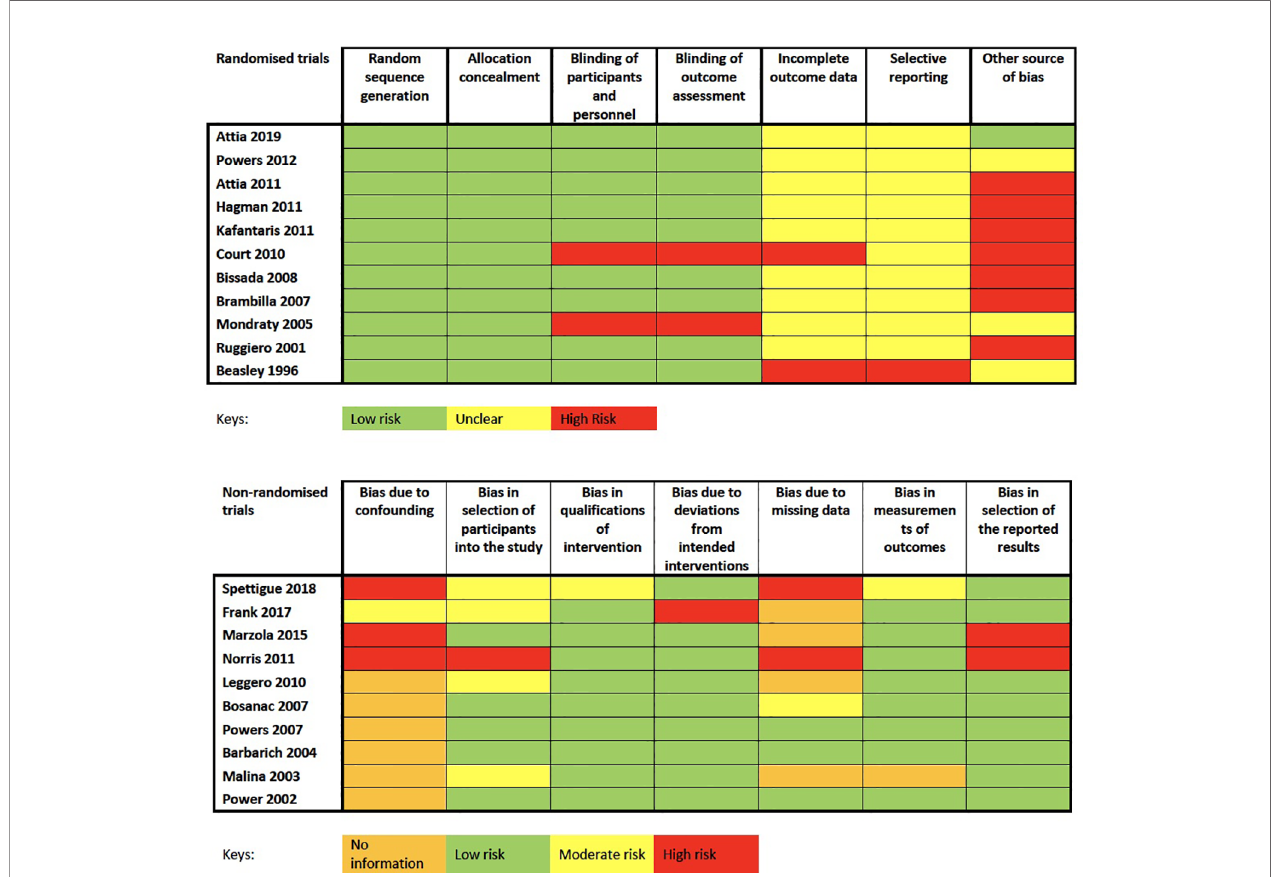
FIGURE 2 | Cochrane Collaboration's tool for assessing risk of bias for randomized trials and Risk of Bias in Non-randomized Studies-of Interventions (ROBINS-I) assessment tool for non-randomized